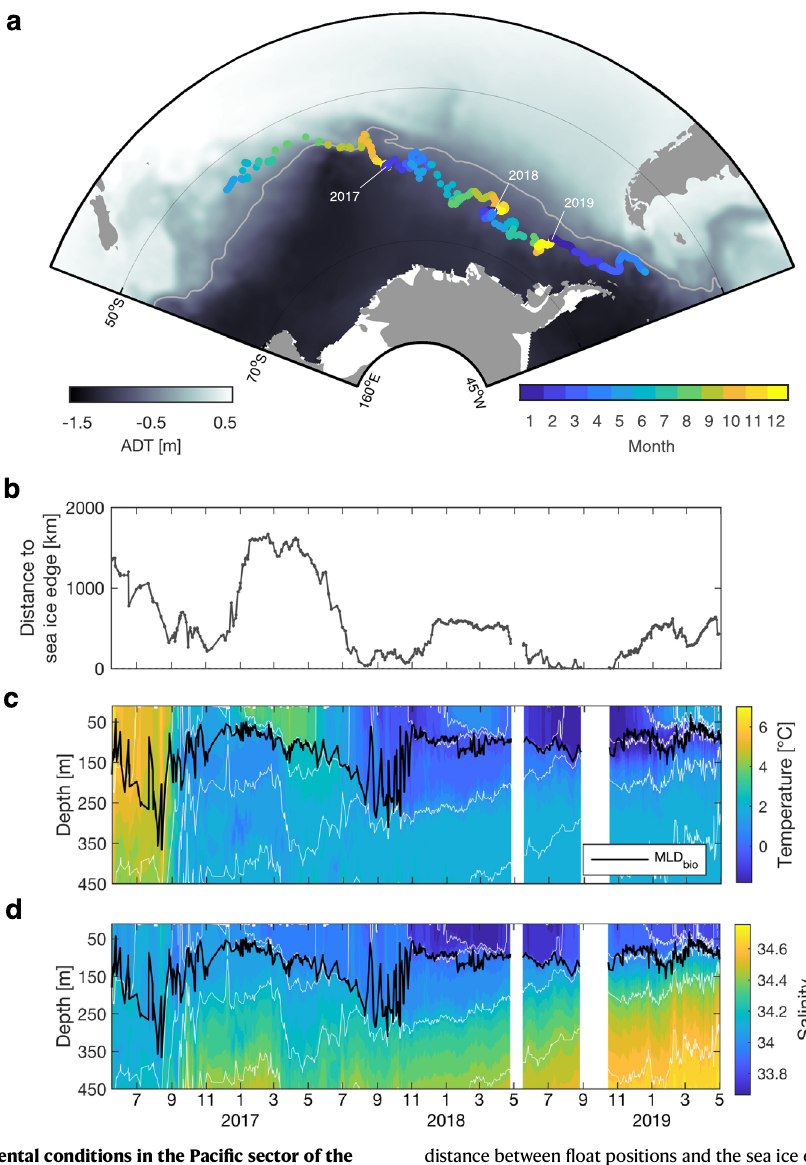
distance between fl oat positions and the sea ice edge, de fi ned as the 15% sea ice concentration limit. Vertical sections of c temperature and d salinity recorded by the fl oat. Light grey lines are isopycnals and the dark line is the mixing layer depth as de fi ned by biological criteria (MLD bio , see Methods). Periods with missing data are blank in panels c and d